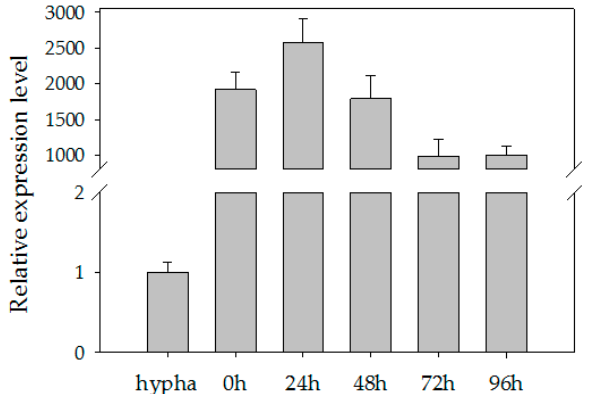
Figure 1. PITG_15718.2 is upregulated in sporangia and during the early stages of infection. The hyphae were scraped with a glass rod from the plants on which P. infestans grew at 18 °C for two weeks. The sporangia were collected from the suspension, then incubated on ice and stored at 4 °C for 3 h to release the zoospores. The PITG_15718 expression level was assessed by qRT-PCR at 0, 12, 24, 48, 72 and 96 h after inoculation of P. infestans . Error bars represent SD of the mean values of three biological replicates. The experiment was repeated three times with similar